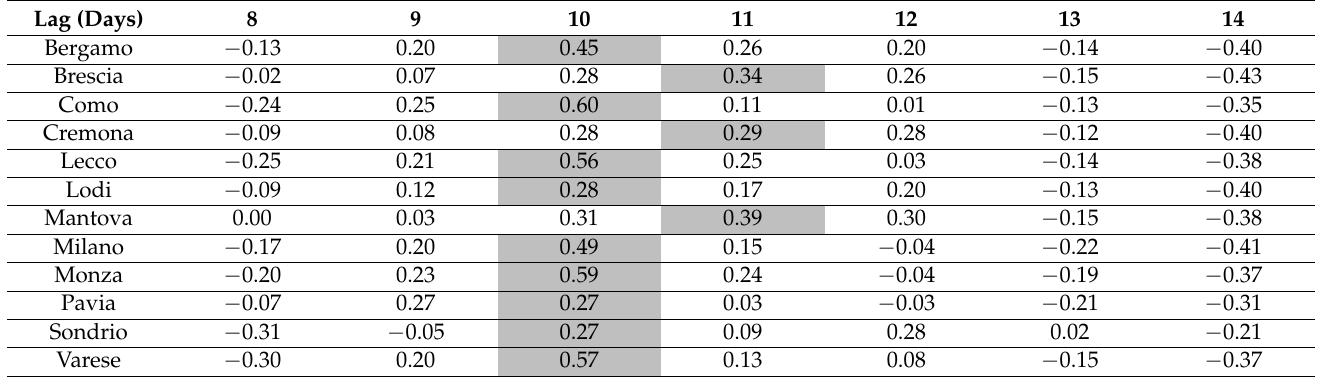
Table 2. Cross-correlation values between the daily incidence of infection and the PM2.5 concentration obtained varying the lag between the two series.